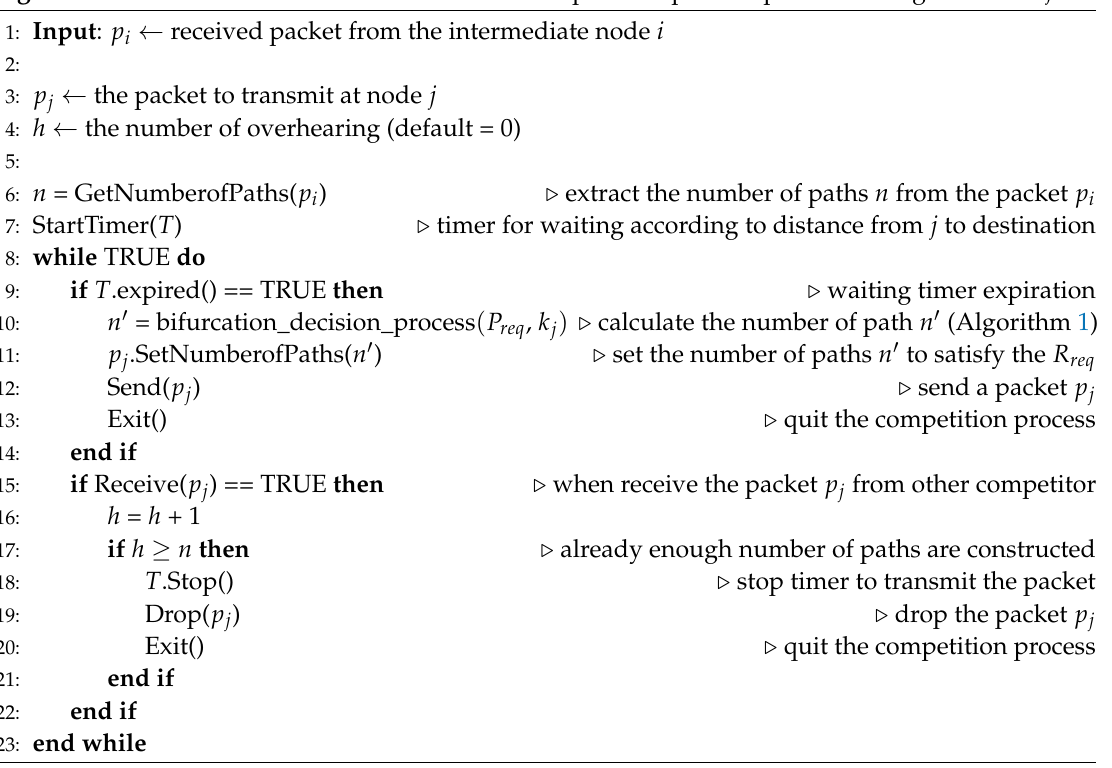
Algorithm 2 Pseudocode for the receiver-based transport competition process at neighbor node